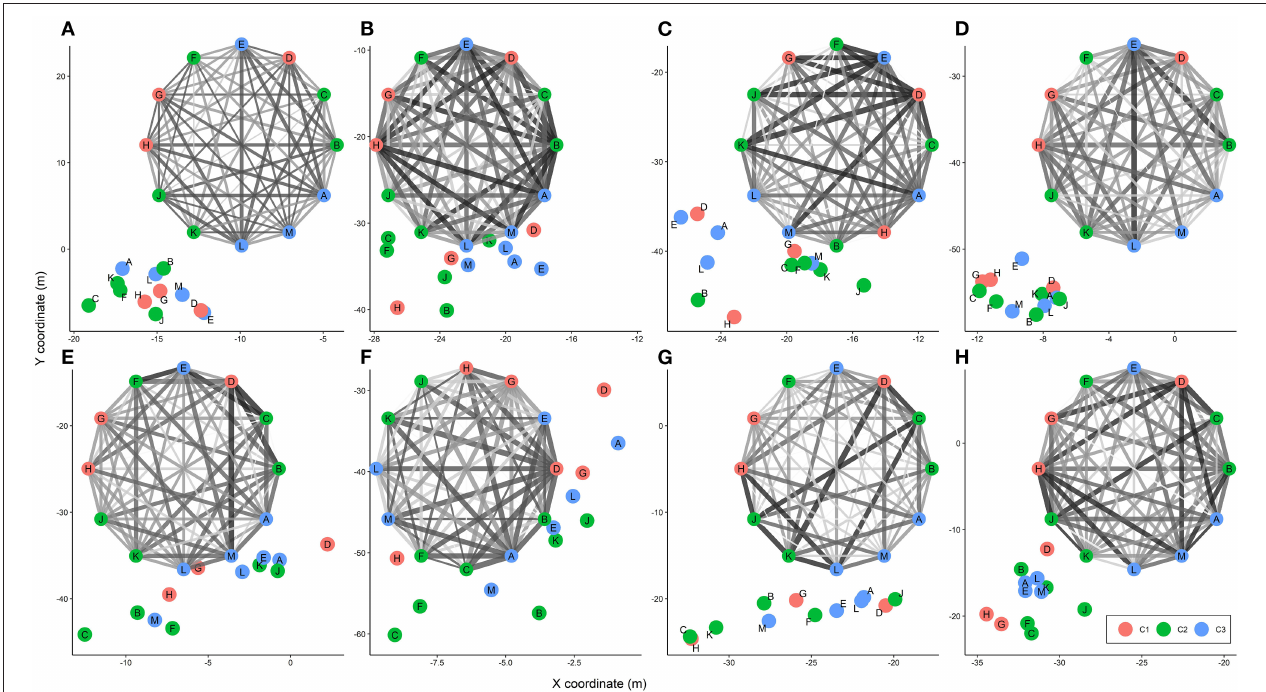
FIGURE 5 | Animal social groups for 8h [ (A–H) ] of the first study day based on social network analysis and GNSS positional data in cohort 1. C1, cluster 1 (bold animals); C2, cluster 2 (fearful animals); and C3, cluster 3 [bold toward a novel object but fearful of a human (bold/fearful)]. In both the social network and GNSS positional plots, letters in the vertices (nodes) refer to individual animals and edges show the distance between two animals where a thinner (lighter) line corresponds to a shorter distance and vice versa.